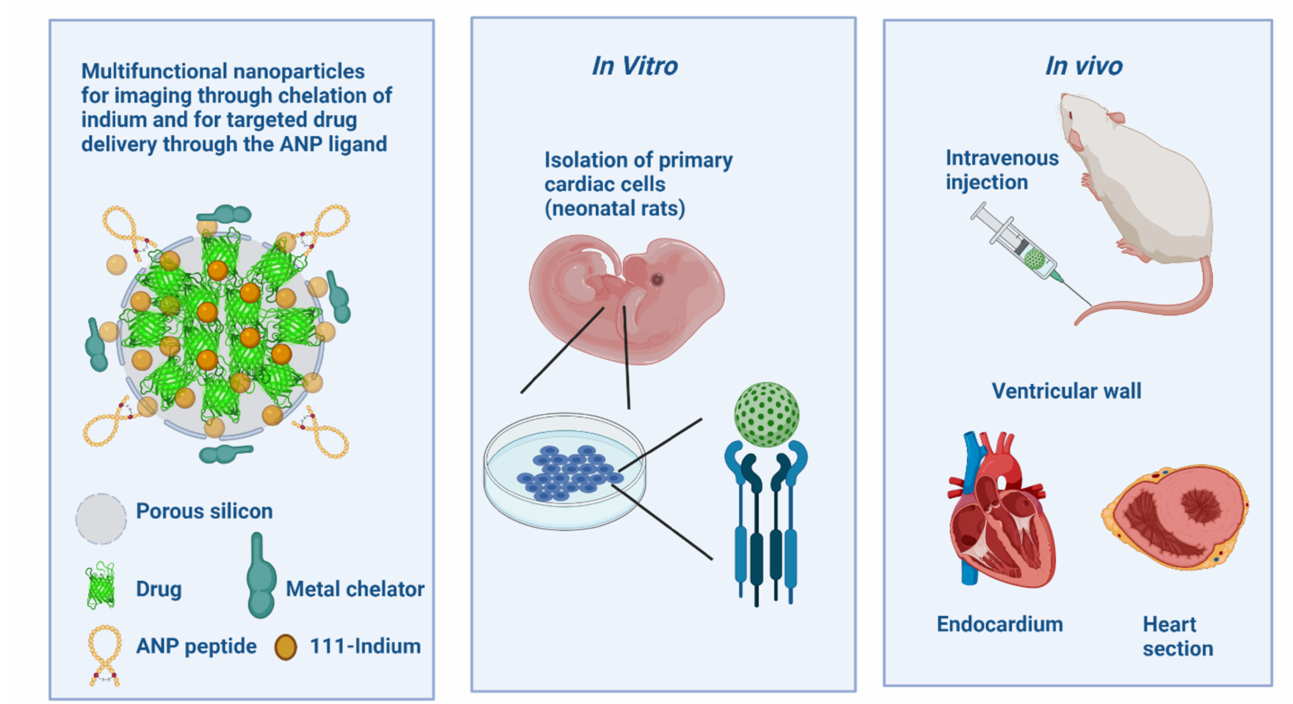
Figure 7. In vitro–in vivo correlation as a predictor of in vivo performance. Preclinical characteri- zation of new nanotechnology-based formulations presents several challenges at different stages of their development: physicochemical characteristics, sterility, safety, and efficacy. The generally low sensitivity of standard in vivo toxicity tests to immunotoxicity, the interspecies variability in immune system structure and function, the high costs and relatively low throughput of in vivo tests, and ethical concerns about the use of animals, underscore the need for reliability in vitro assays. Correlation of in vitro and in vivo studies is required to ensure a more reliable transition to preclinical and clinical use. The figure shows cytocompatibility and cell-nanoparticle interaction. This method is very reliable for investigating the biocompatibility, biodistribution, and intramyocardial localiza- tion of cardiac-targeted NPs. After obtaining the results, the NPs can deliver a new molecule drug and evaluate its function in an animal model, thus establishing in vitro and in vivo correlation as strong evidence for further formulation development. ANP: Atrial natriuretic peptide. Created with BioRender.com (accessed on 10 December